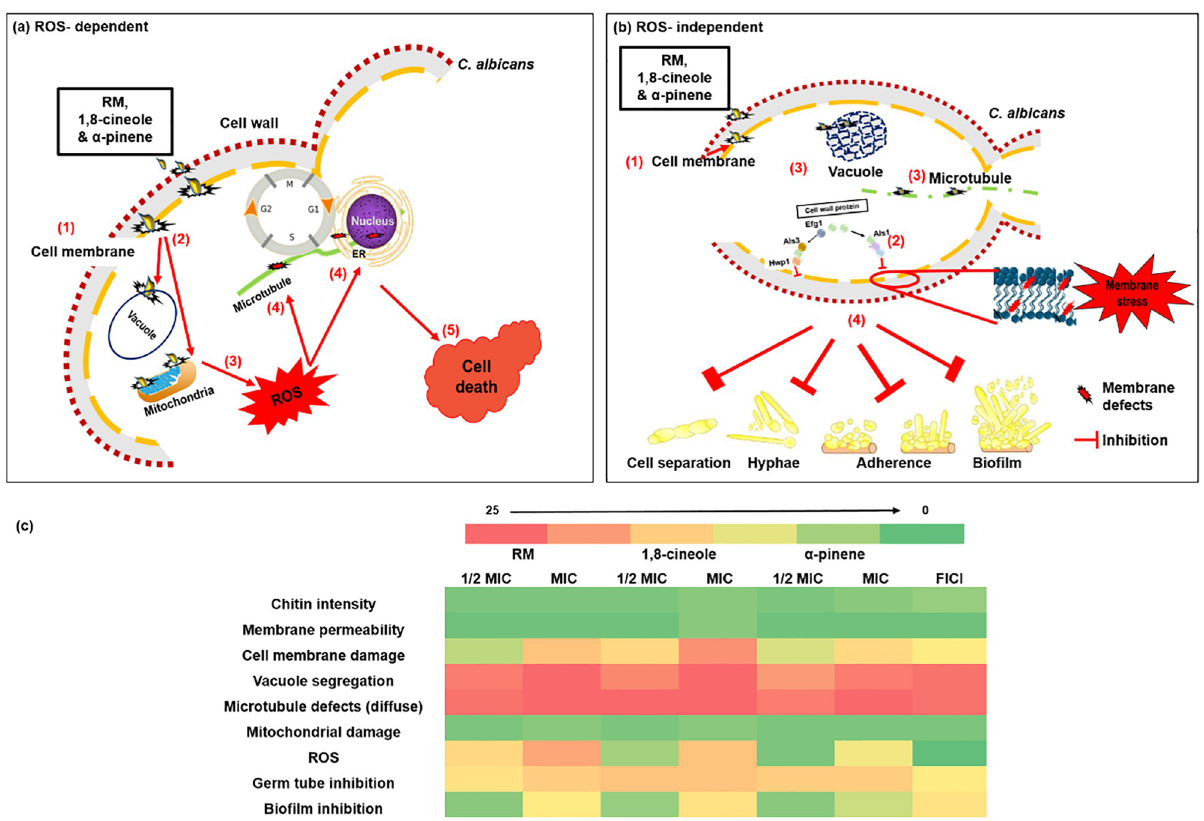
Fig 8. Cartoon representation of potential C . albicans biological pathways and overall impact by RM oil and its major components. (a) At higher concentrations (1/2 to full MIC), EOCs can pass through the C . albicans cell wall and gain access to (1) the cell membrane, wherein they cause membrane depolarization. (2) Once EOCs pass through the cell membrane they can enter the membrane of other organelles, such as vacuoles, mitochondria and the nucleus. (3) Mitochondria are the main source of cellular ROS, in which membrane damage would lead to cellular stress and accumulation of ROS, which subsequently (4) causes damage to macromolecules (e.g. MTs) and (5) eventually cell death. (b) At lower fractional MIC, EO(C)s also diffuse through the cell wall and (1) enter through the cell membrane, where they cause (2) membrane defects, proposed to retard major cell wall virulence proteins from passing through and reaching the cell wall surface. This would impact important cell wall virulence proteins, including Als1, Als3, Hwp1, which play an important role in adhesion, biofilm and hyphal formation. (3) Direct impacts of EO(C)s on vacuoles and MTs also play an important role in (4) inhibiting hyphal formation. Abnormal MT morphology can also contribute to the cell separation defects, which lead to pseudohyphal growth. (c) Heat map of major impacts to C . albicans RSY150 treated with RM oil and its components, 1,8-cineole and α –pinene. Colour scale indicates fold change in parameter with EO(C) exposure. The major C . albicans impacts associated with RM oil are attributable to 1,8-cineole, which accounts 53% of the essential